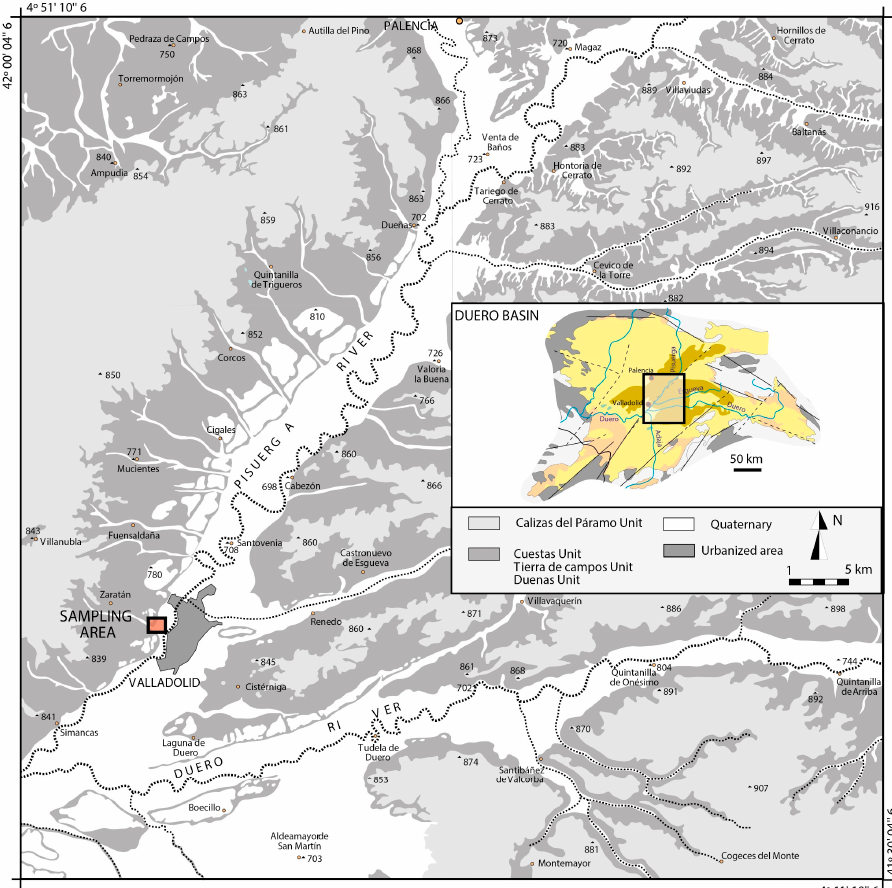
Figure 1. Geological map of the central area of the Duero Basin (modified from Yenes et al. 2015).